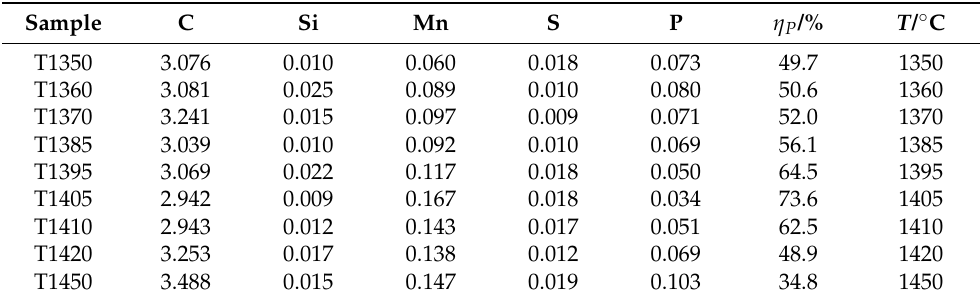
Table 2. Hot metal compositions, dephosphorization ratios, and temperatures at the end of dephos- phorization (mass%).